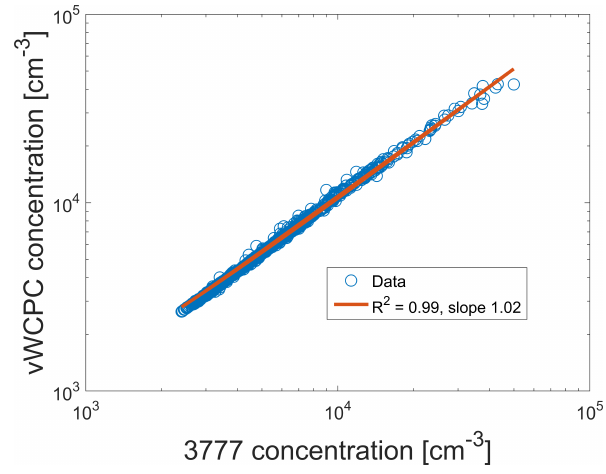
Figure 8. Detection efficiency of the CPCs as a function of size for negatively and positively charged tungsten oxide particles that are neutralized at high dT settings.